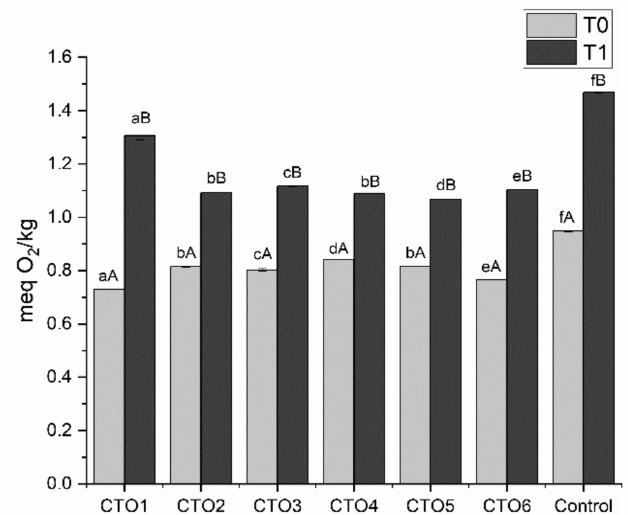
Figure 3. Peroxide analysis results for all organogel and control samples for both times of assessment T0 (0 days) and T1 (2 months). Different small letters indicate statistically significant differences between different concentration within the same organogelator, while different capital letters indicate statistically significant differences between different time assessments of the same organogel ( p <